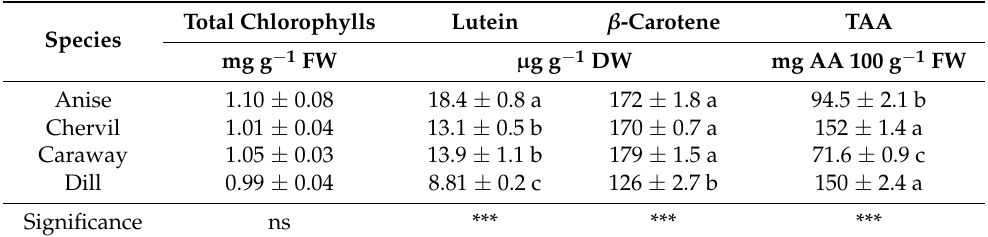
Table 3. Total chlorophylls, carotenoids, and total ascorbic acid (TAA) concentrations of four Apiaceae microgreens grown in controlled environment conditions. Total Chlorophylls Lutein β -Carotene TAA Species mg g − 1 FW Anise 1.10 ± 0.08 Chervil 1.01 ±